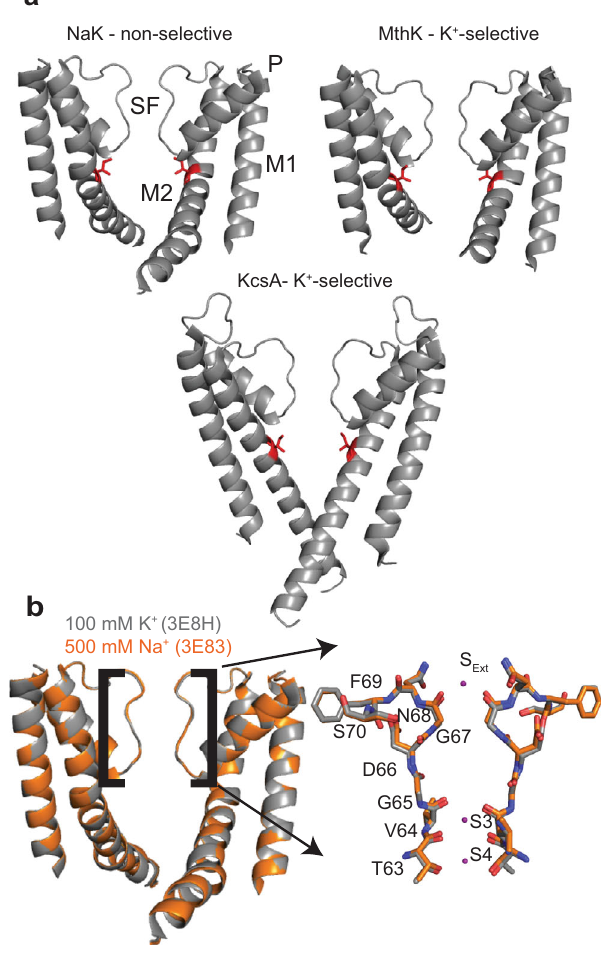
Fig. 1 NaK channel structural comparisons. a Structures and selectivities of 3 bacterial ion channels, NaK (3E8H [10.2210/pdb3E8H/pdb]), MthK (3LDC [10.2210/pdb3LDC/pdb]), and KcsA (1K4C [10.2210/pdb1K4C/ pdb]). The selectivity fi lter (SF) along with M1, P, and M2 helices are labeled for NaK. Residue I88, I84, and I100 is highlighted in red on NaK, MthK, and KcsA structures respectively. b Overlay of NaK structures determined in 100 mM K + (3E8H [10.2210/pdb3E8H/pdb]) and 500 mM Na + (3E83 [10.2210/pdb3E83/pdb]). The SF along with M1, P, and M2 helices are labeled. The SF is enlarged on the right with residue labels. Ion binding sites are labeled and K + ions modeled in the 3E8H [10.2210/ pdb3E8H/pdb] structure are shown as well. In both panels, two opposing of four total subunits are shown for